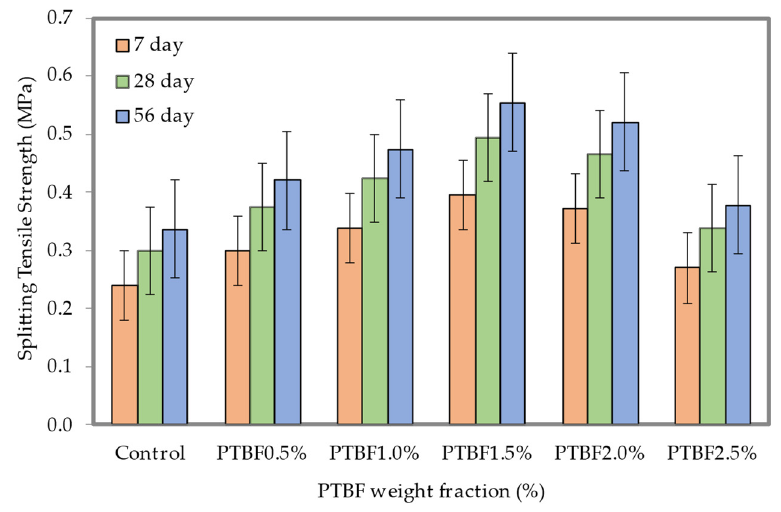
Figure 19. Tensile strength of 700 kg/m 3 density LFC with different weight fractions of PTBF.